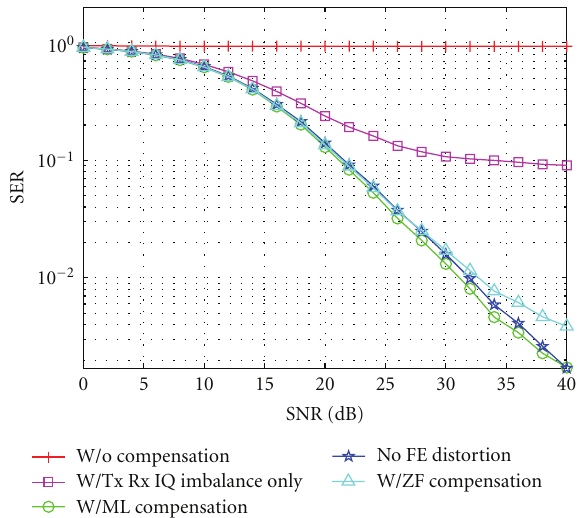
Figure 9: Preamble pilot-based SER versus SNR performance curves for 64-QAM OFDM system. Tx/Rx FE IRR = 20–30 dB; veh. A channel model with 39 taps; ensemble average over 1000 independent channel realizations.